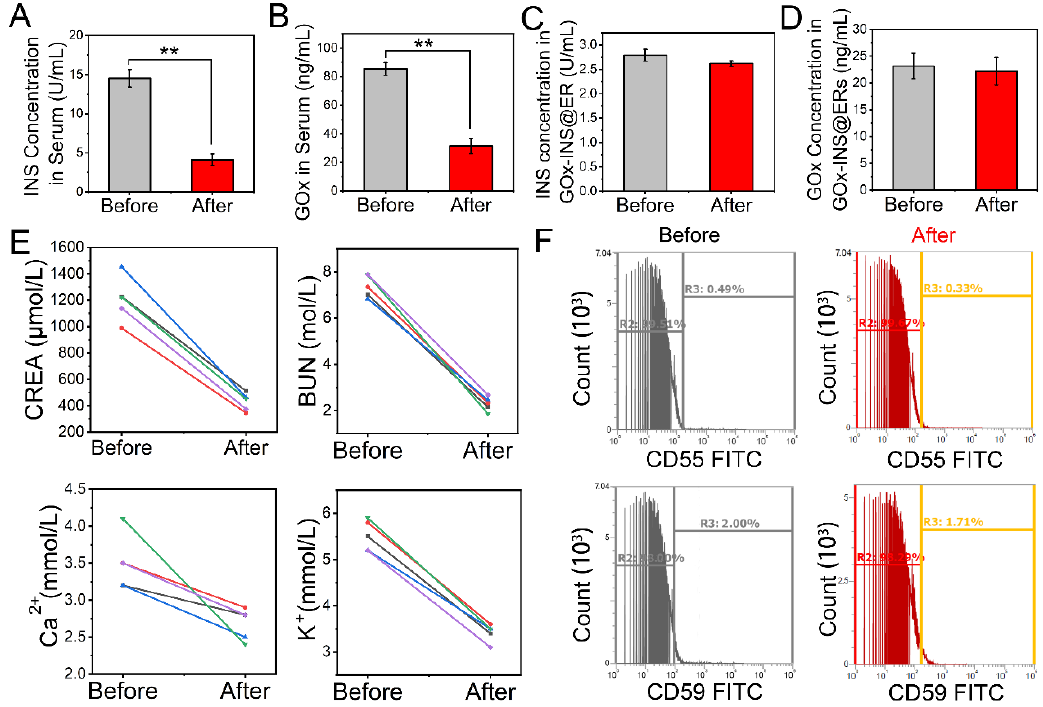
Figure 3. Changes in blood parameters during the hemodialysis process of the CAER platform. ( A ) Mean concentration changes in unencapsulated INS in the serum. ( B ) Mean concentration changes in unmodified GOx from GOx-INS@ERs. ( C , D ) Effects of hemodialysis on the INS concentration and GOx in the GOx-INS@ERs. ( E ) CREA, BUN, Ca 2+ , and K + concentrations before and after hemodialysis. ( F ) Surface expression levels of CD55 and CD59 on GOx-INS@ERs and natural ERs measured by flow cytometry. ** p <